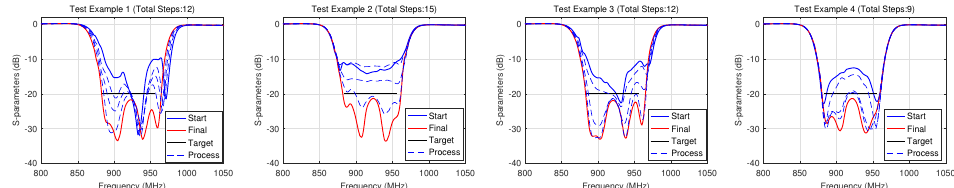
Figure 11. Test experimental results of a trained model for the four-screw filter. The frequency passband is within the range of [ 883,956 ] MHz. The initial screw positions are randomly set. In most test episodes, the filter could be successfully tuned to meet the target in no more than 20